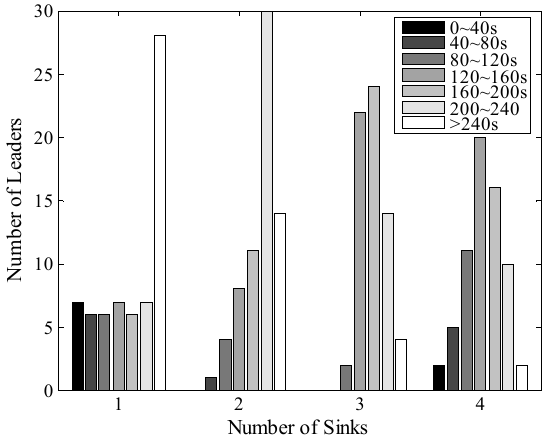
Figure 27. Time interval of two consecutive times of data upload (200 m × 200 m, 500 nodes).